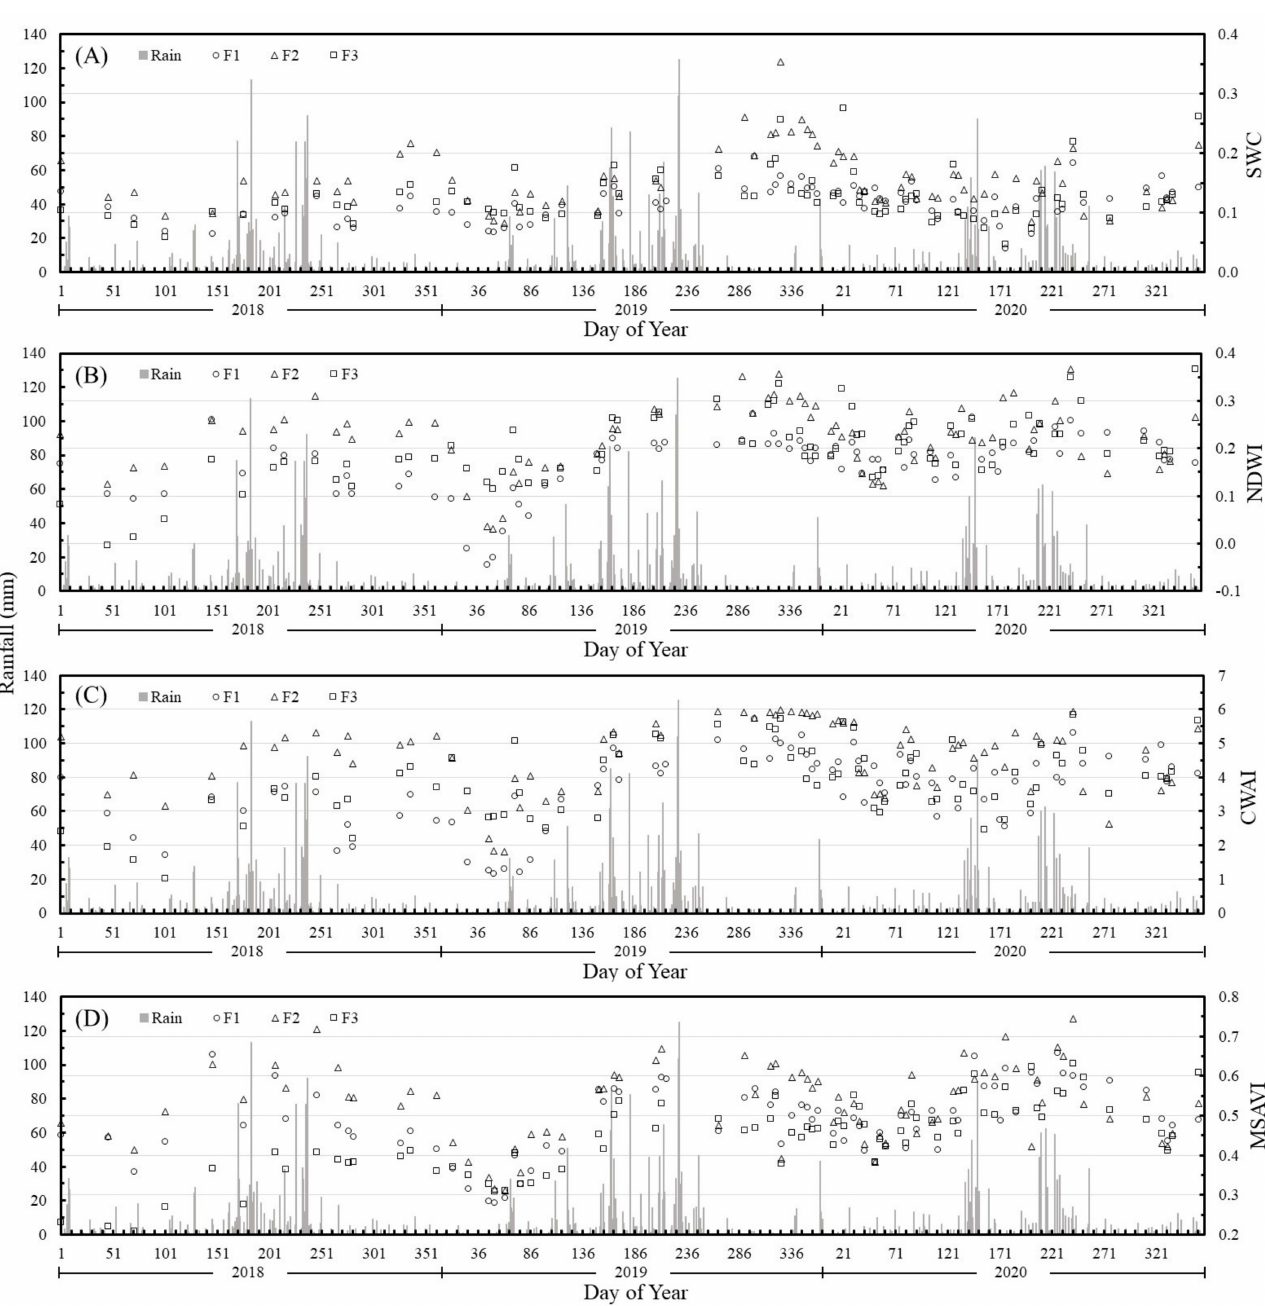
Figure 4. Changes in ( A ) soil water content (SWC); ( B ) normalized difference water index (NDWI); ( C ) crop water availability index (CWAI); ( D ) modified soil-adjusted vegetation index (MSAVI), at three ground data collecting plantations from 2018 to